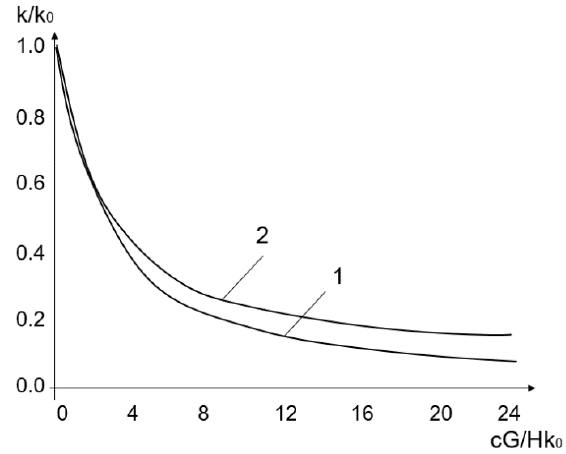
Figure 19. Relative heat transfer coefficient of the ventilated facade: 1 — double glazing, 2 — triple glazing.